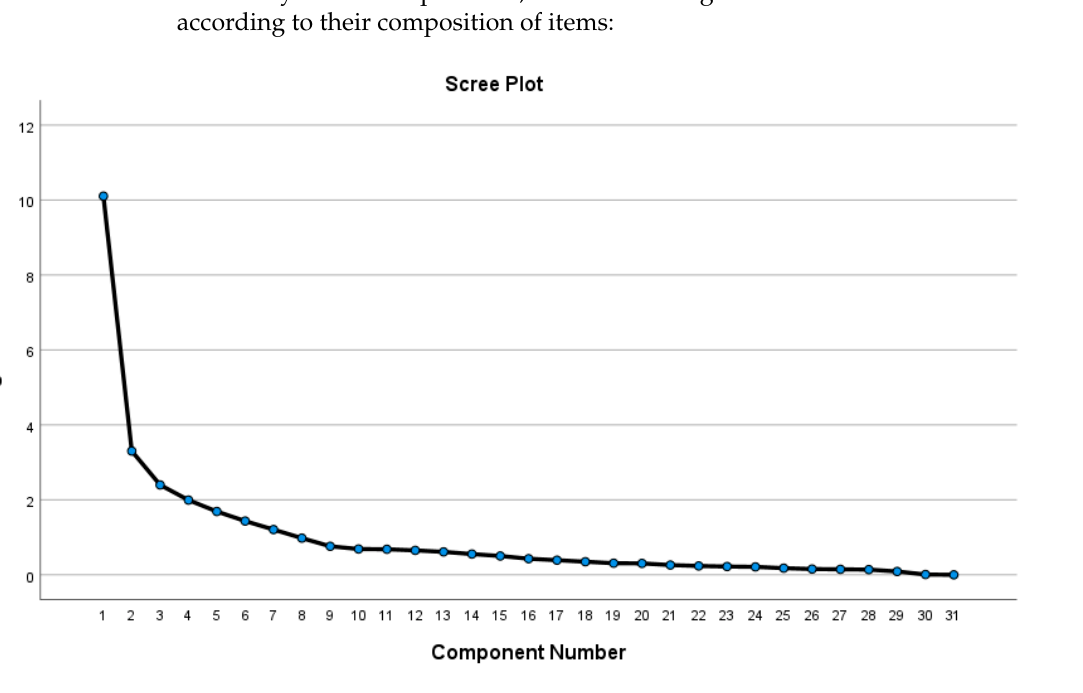
Figure 1. Factors Scree Plot for occupational health and safety standards practices in the mining industr